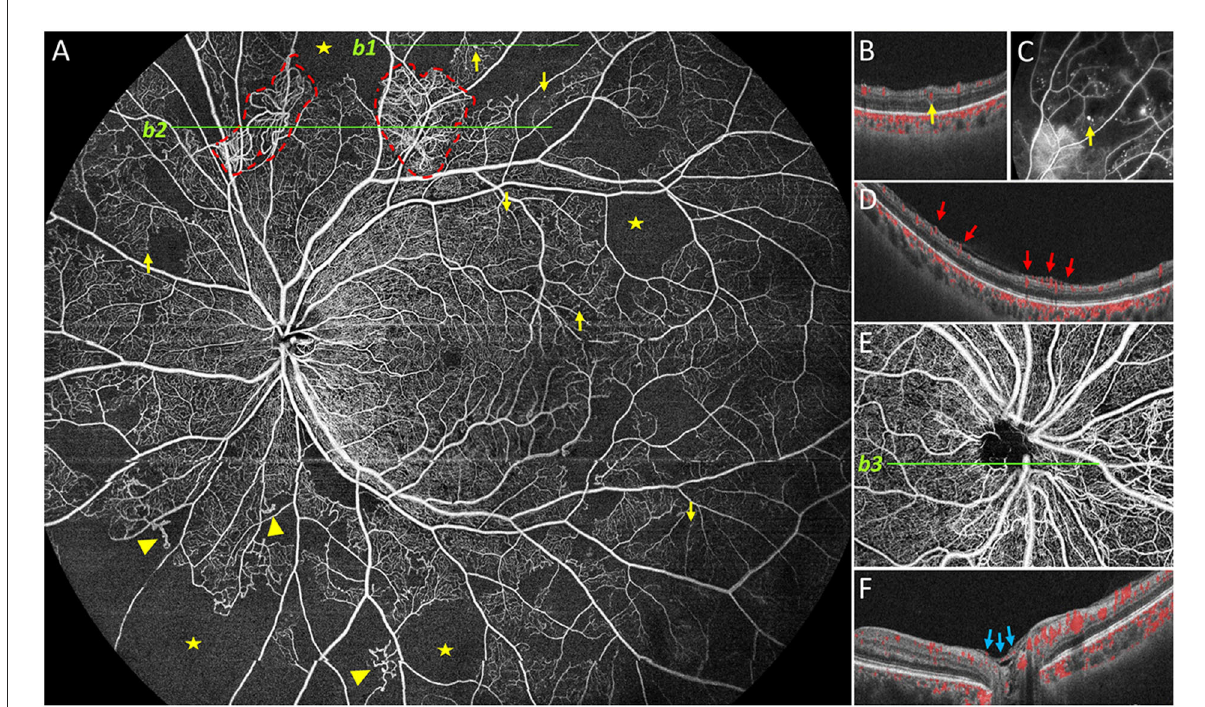
FIGURE1 Representative 24 × 20mm image obtained by UWF SS-OCTA. Representative DR lesions were marked with yellow arrows for microaneurysms (MA), solid triangles for intraretinal microvascular abnormalities, red dashed line for neovascularization elsewhere, pentastar for nonperfusion area, blue arrow for neovascularization of the disc (NVD). In case, neovascularization was found elsewhere on (A , b2 ), and corresponding B-scan is provided on (D) ; B-scan ( b1 ) of the MA near the superior edge of (A) is shown in (B) , and corresponding FFA image is provided in (C) . In another case, NVD was found and a corresponding B-scan is shown (E,F)